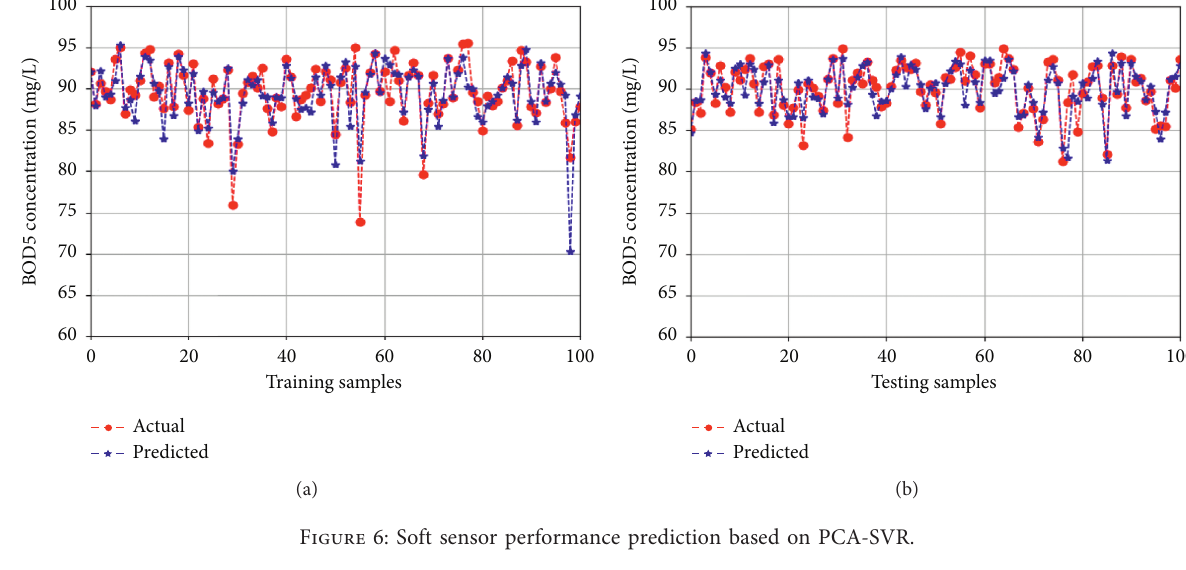
Figure 6: Soft sensor performance prediction based on PCA-SVR.